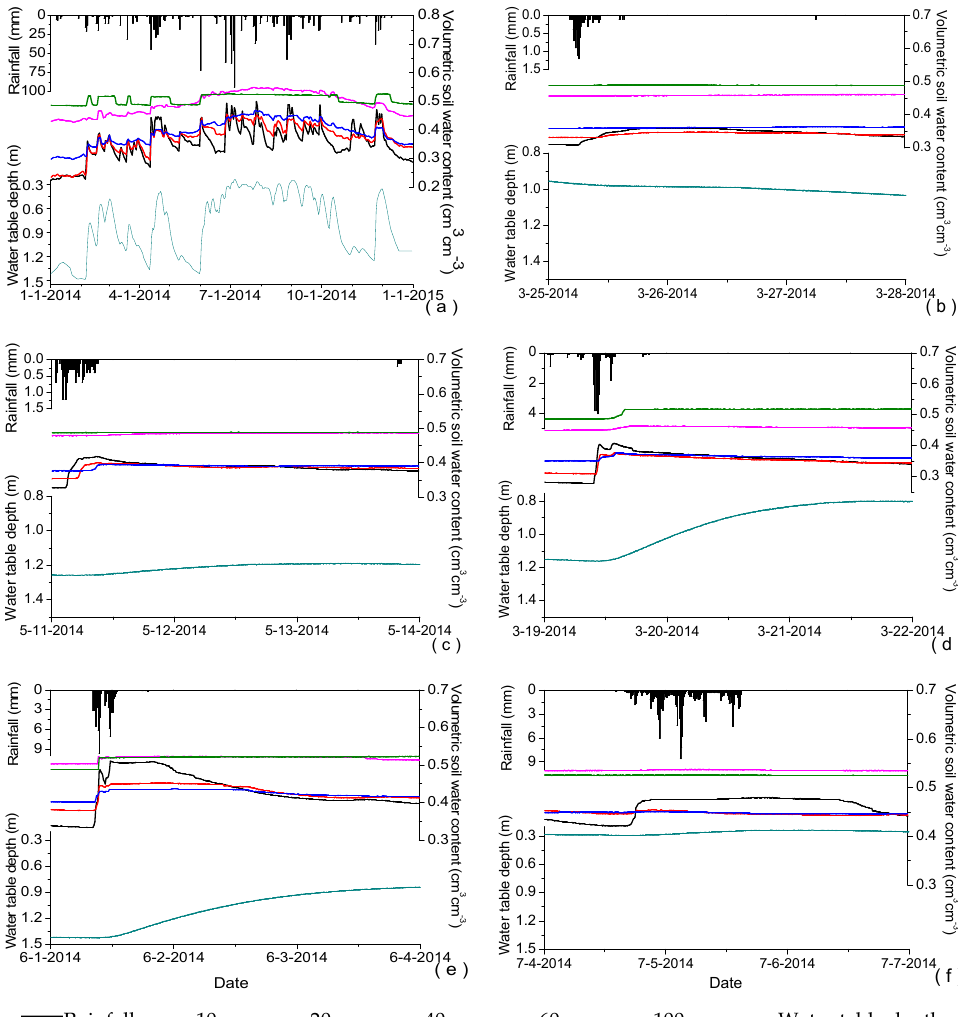
Figure 5. Rainfall conditions: ( a ) Shallow water table and soil water contents at 0.10, 0.20, 0.40, 0.60 and 1.00 m soil depths during 2014; ( b – f ) changes under five different rainfall conditions.